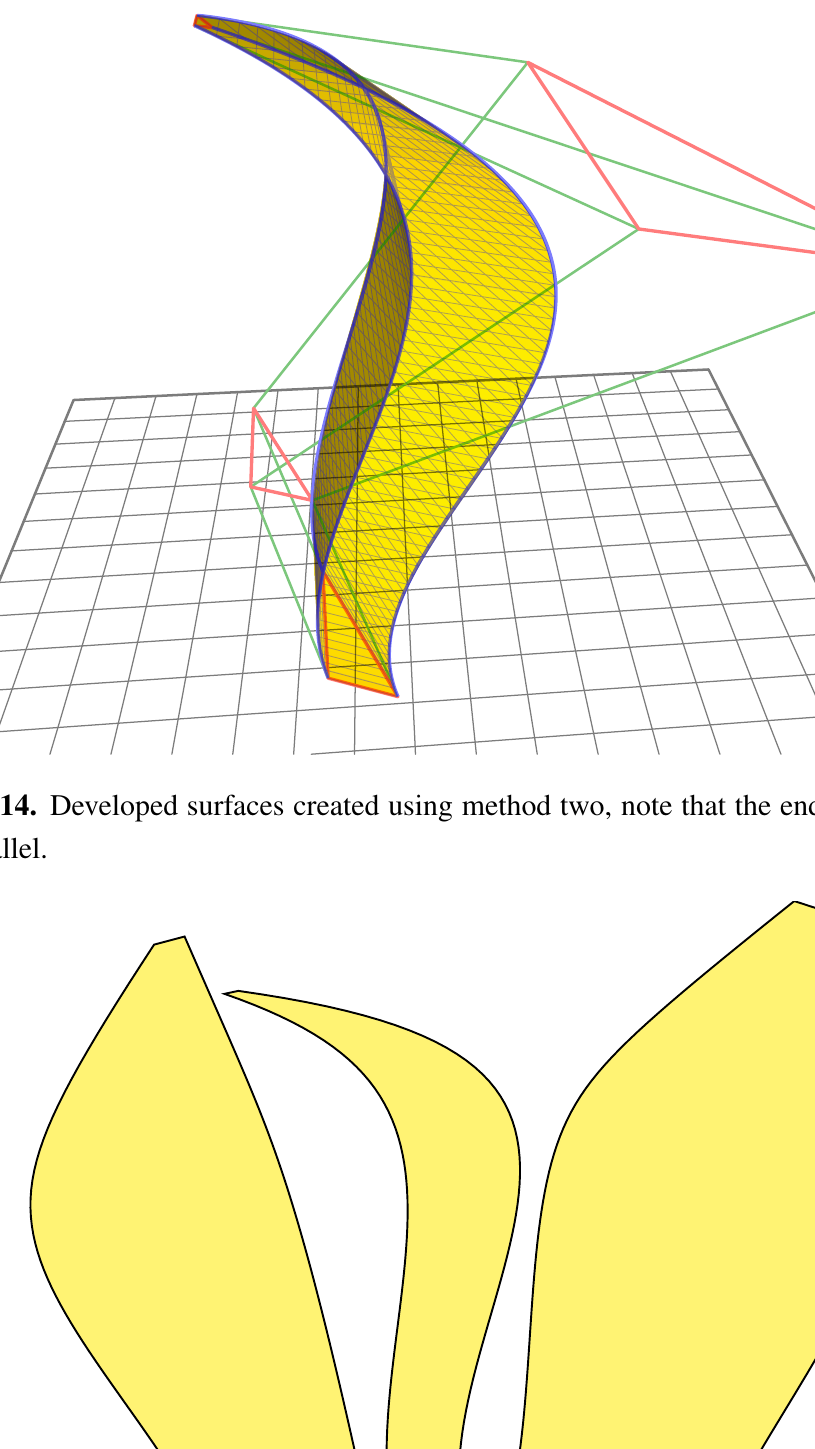
Figure 13. Ruled surfaces between splines drawn between homothetic polylines.